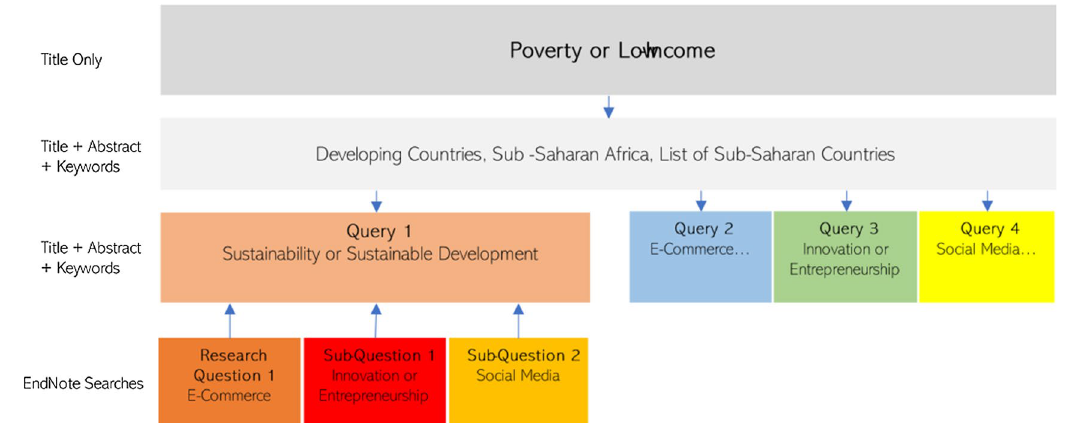
Fig. 2 Search Structure